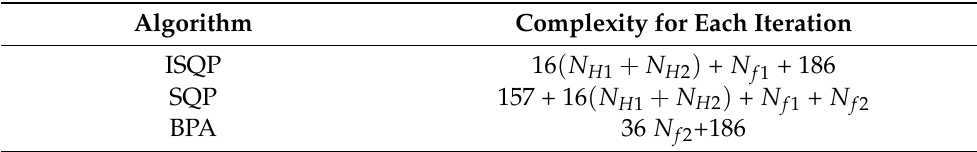
Table 3. Complexity Analysis for SISO under Imperfect Channel Estimation.